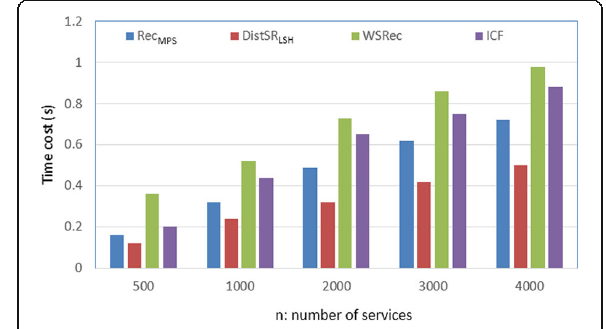
Fig. 2 Efficiency comparisons (w.r.t. n ) ( m = 142) . DistSR LSH , Rec MPS , WSRec, ICF